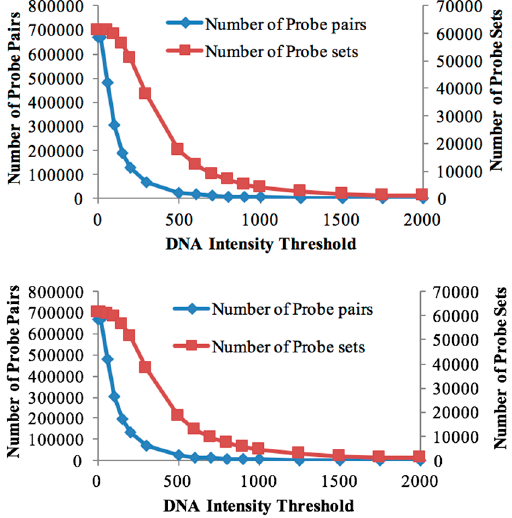
Figure 1. Effect of intensity thresholds. Number of probe pairs (blue line) and probe sets (magenta line) retained for DipC ( top ) and Tiga Nicuru (TN) ( bottom ) respectively at different genomic DNA (gDNA) intensity thresholds.